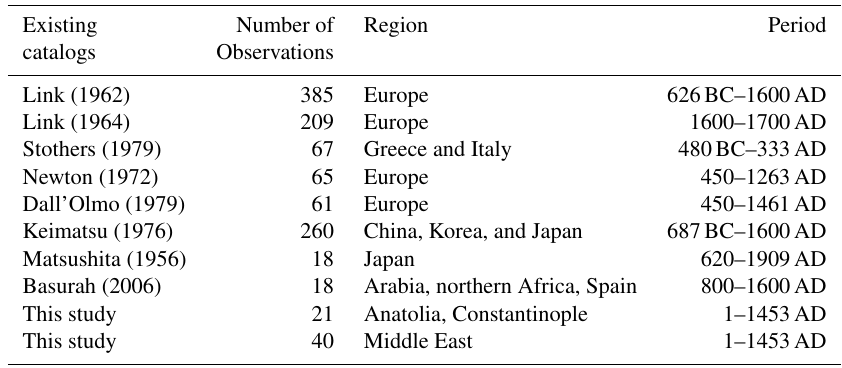
Table 1. Historical aurora catalogs compiled by different authors. Existing Number of